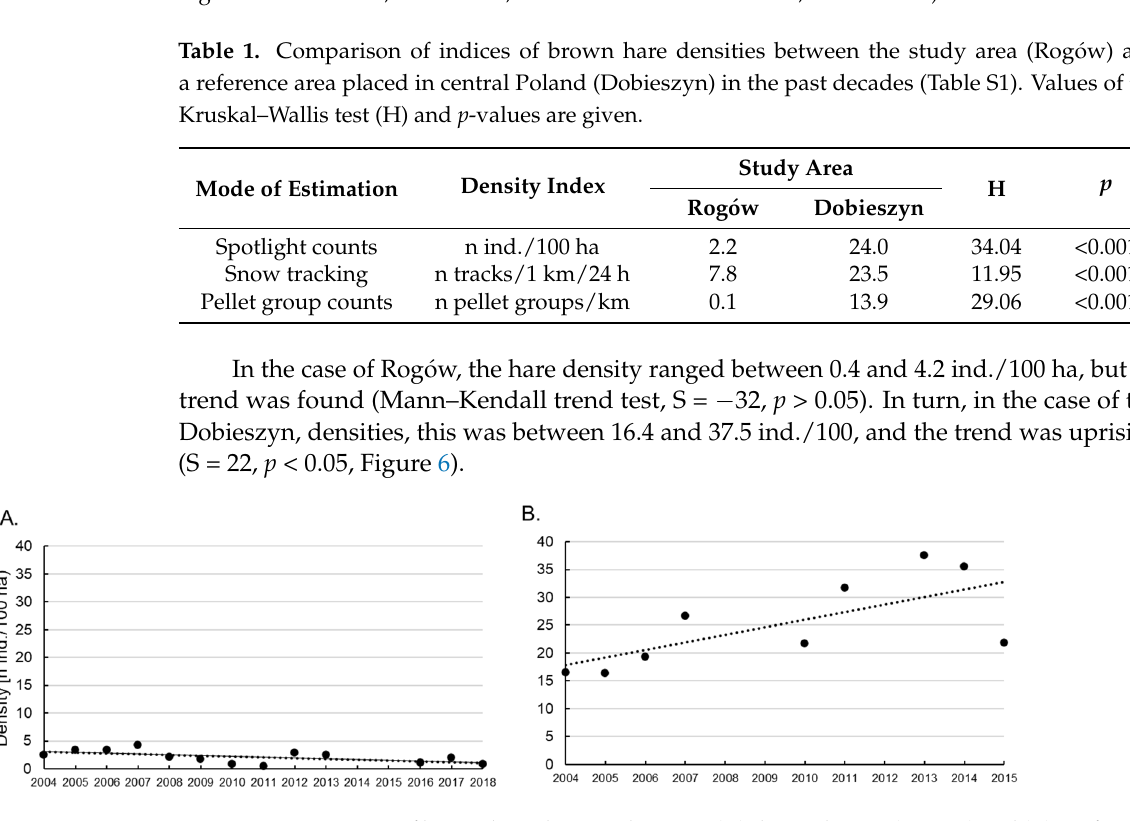
Table 2. Comparison of red fox density indices between the study area (Rogów) and a reference area placed in central Poland (Dobieszyn), in the past decades (Table S1). Values of Kruskal–Wallis test (H) and p -values are given.